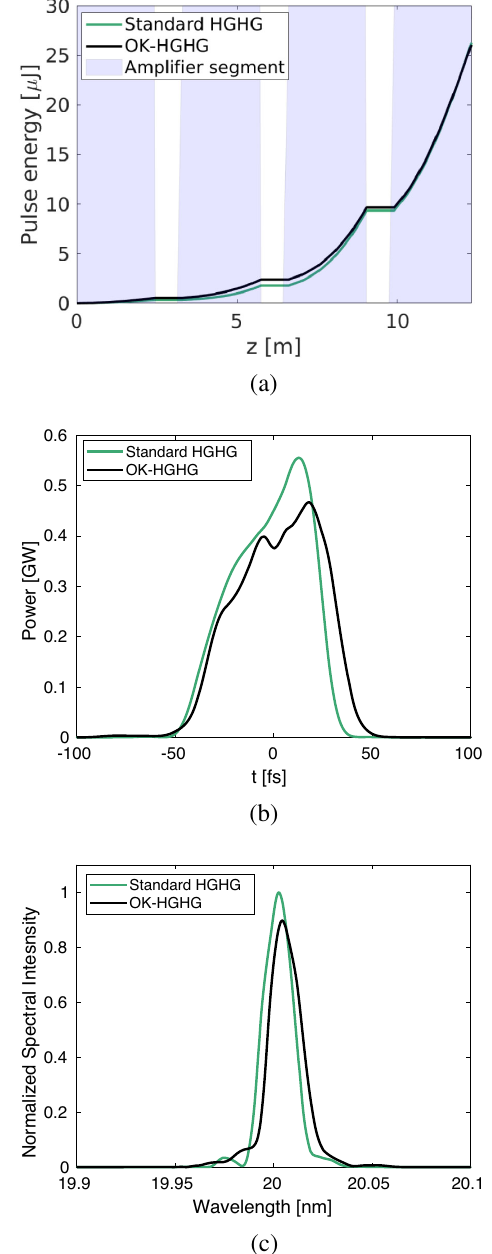
FIG. 6. We compare two fully optimized simulations of a standard HGHG and an OK-HGHG setup for the 15th harmonic of a 300 nm seed laser wavelength. (a) Gain curves in amplifier. (b) Output FEL power profiles. (c) Output FEL spectra normal- ized to the intensity of the standard HGHG simulation.